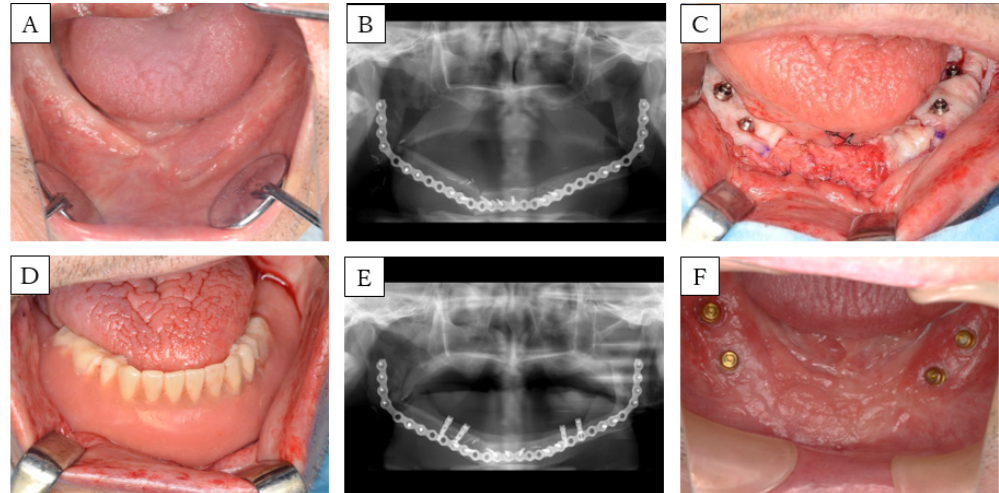
Figure 5. Case 5. ( A ) Preoperative intra-oral picture of the mandibular reconstructions with fibula-free flaps. ( B ) Panoramic radiograph of the patient before implant placement. A single-barrel fibula was placed corresponding to the lower border of the mandible to reconstruct the ablative defect. ( C ) Intra-operative picture: placement of palatal mucosa around the implant. ( D ) Intra-oral picture: rebasing during surgery, installing a temporary abutment, and fixing in dentures using screws. ( E ) Panoramic radiograph and ( F ) intra-oral picture after the FGG.